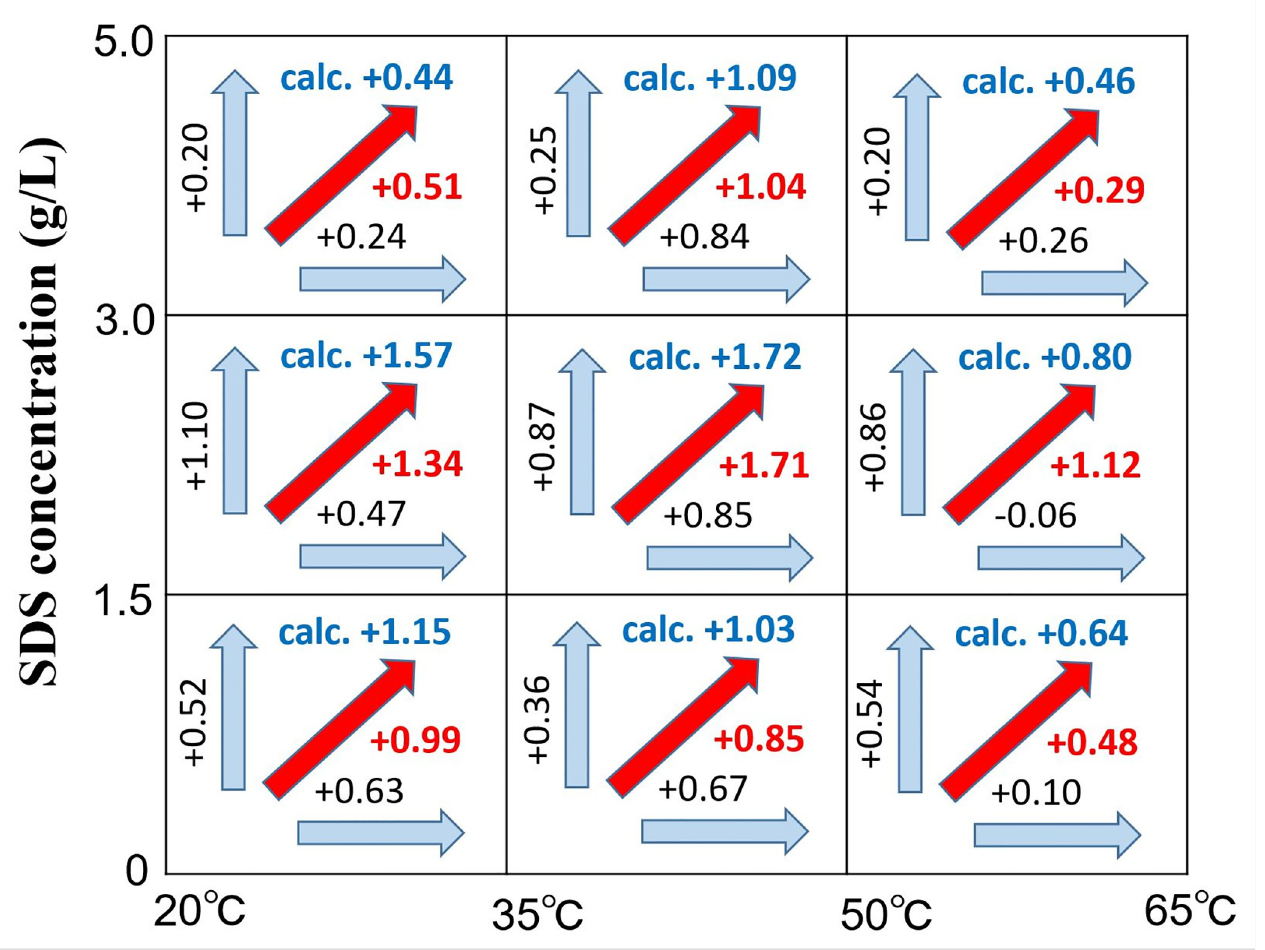
Fig 8. Determination of additive rule between increase in SDS concentration and temperature in hemoglobin cleaning: The increase in μ increase in the SDS concentration is expressed as a vertical value, and that due to an increase in the temperature is expressed as a horizontal value. The increase in μ due to an increase in the SDS concentration and temperature is expressed as a diagonal arrow. Moreover, additivity is confirmed if the calculated rl value (vertical value + horizontal value) is close to the corresponding experimental value (value of red diagonal